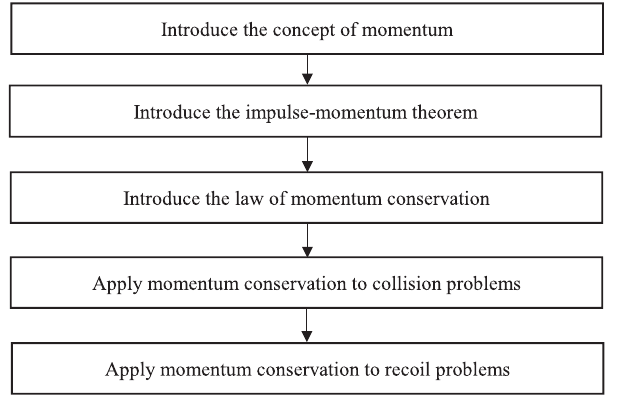
FIG. 9. The process of instruction on momentum in Chinese high schools.